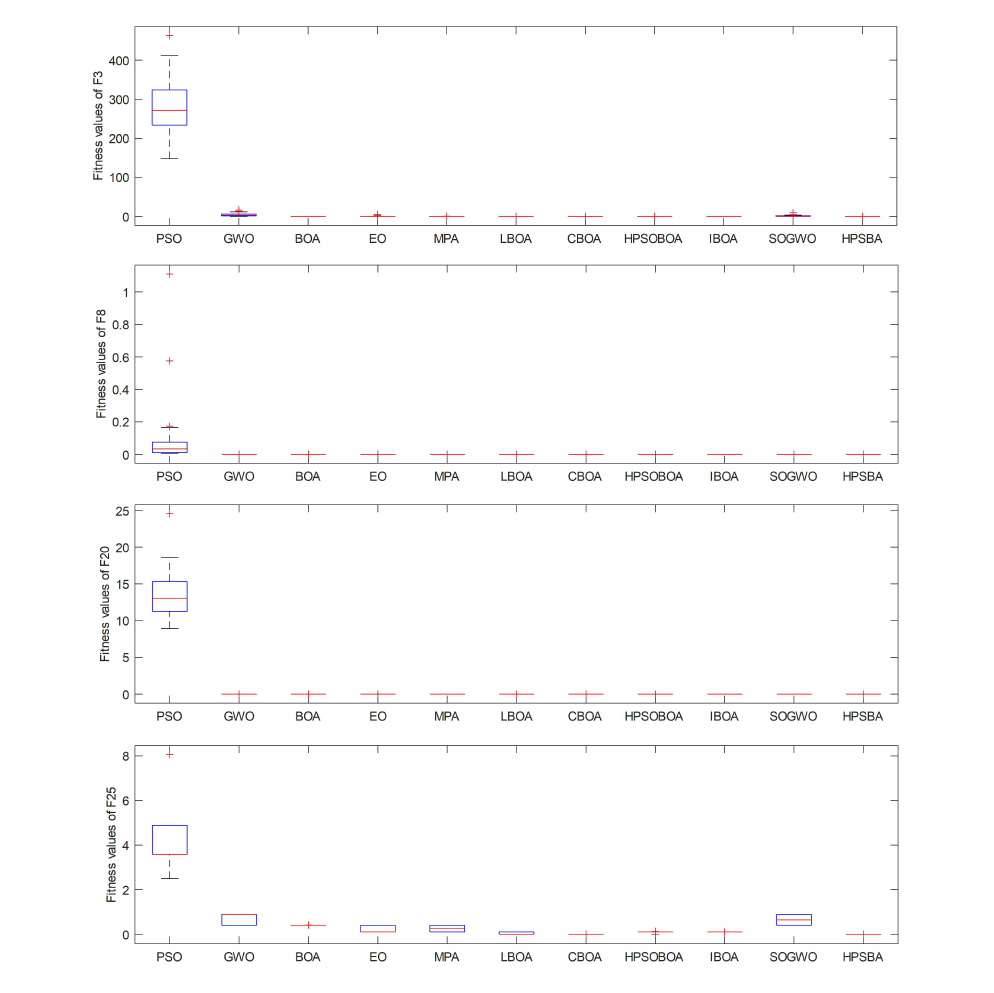
Figure 9. Box plot results for the function F3, F8, F20 and